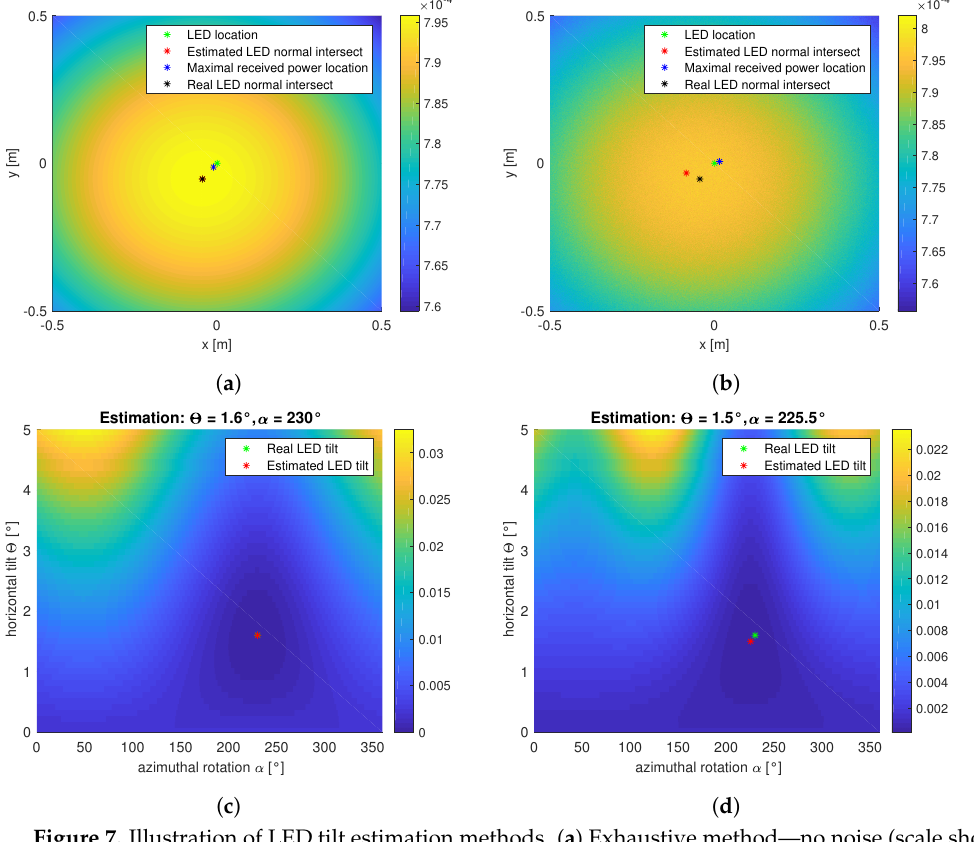
Figure 7. Illustration of LED tilt estimation methods. ( a ) Exhaustive method—no noise (scale showing P R · d 3 , in Wm 3 ); ( b ) Exhaustive method—noise (scale showing P R · d 3 , in Wm 3 ); ( c ) Quick search—no noise (scale showing C tilt ( α , θ ) from Equation (16), dimensionless); ( d ) Quick search—noise (scale showing C tilt ( α , θ ) from Equation (16),